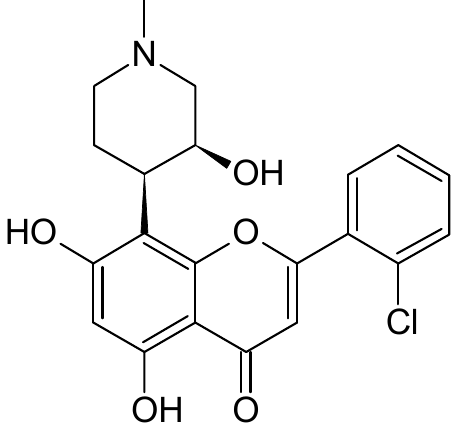
Figure 4. The structure of flavopiridol.